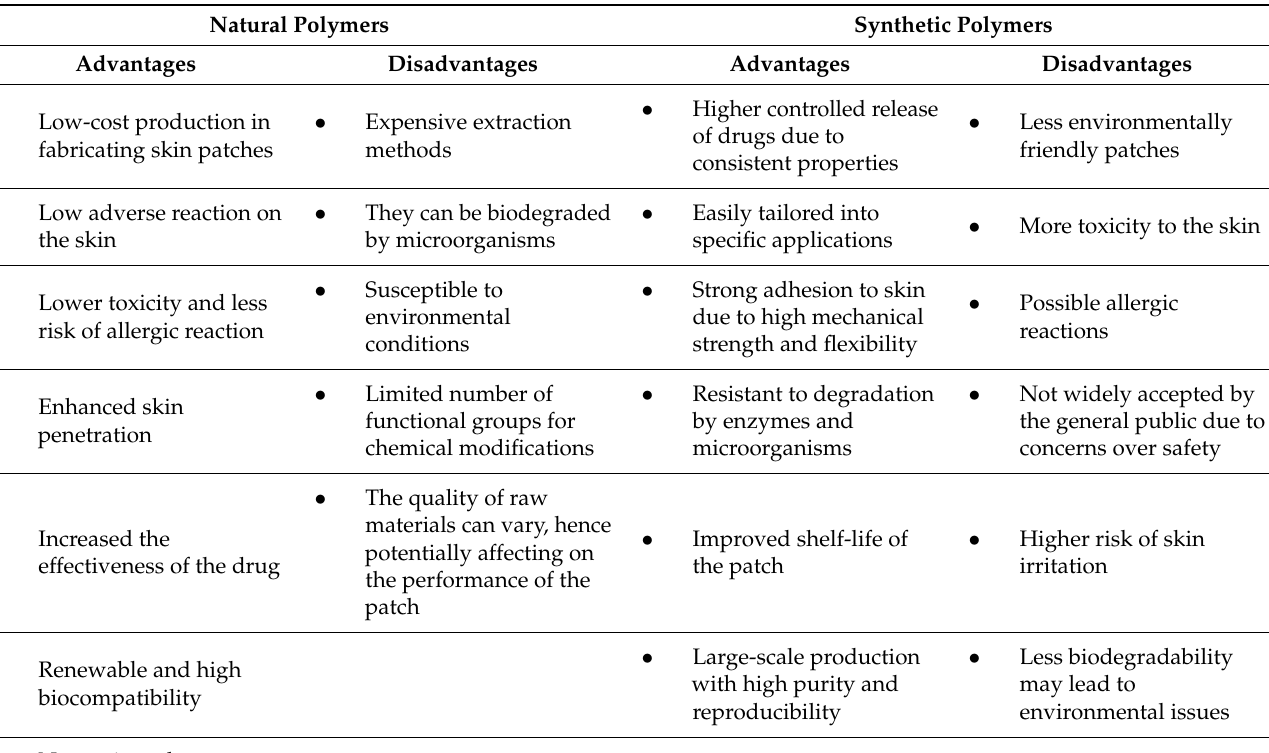
Table 2. Advantages and disadvantages of natural and synthetic polymers used in dermal and transdermal administration of drugs